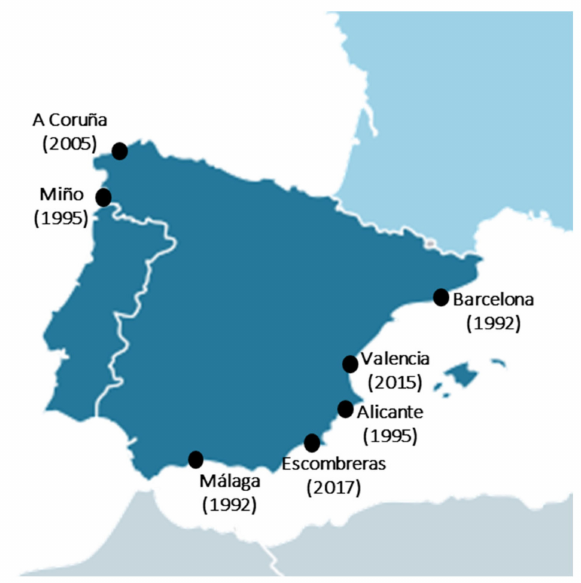
Figure 12. Own experience in nanomaterials works (source: own elaboration).